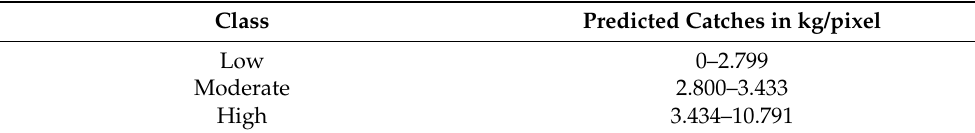
Table 3. Classification of predicted